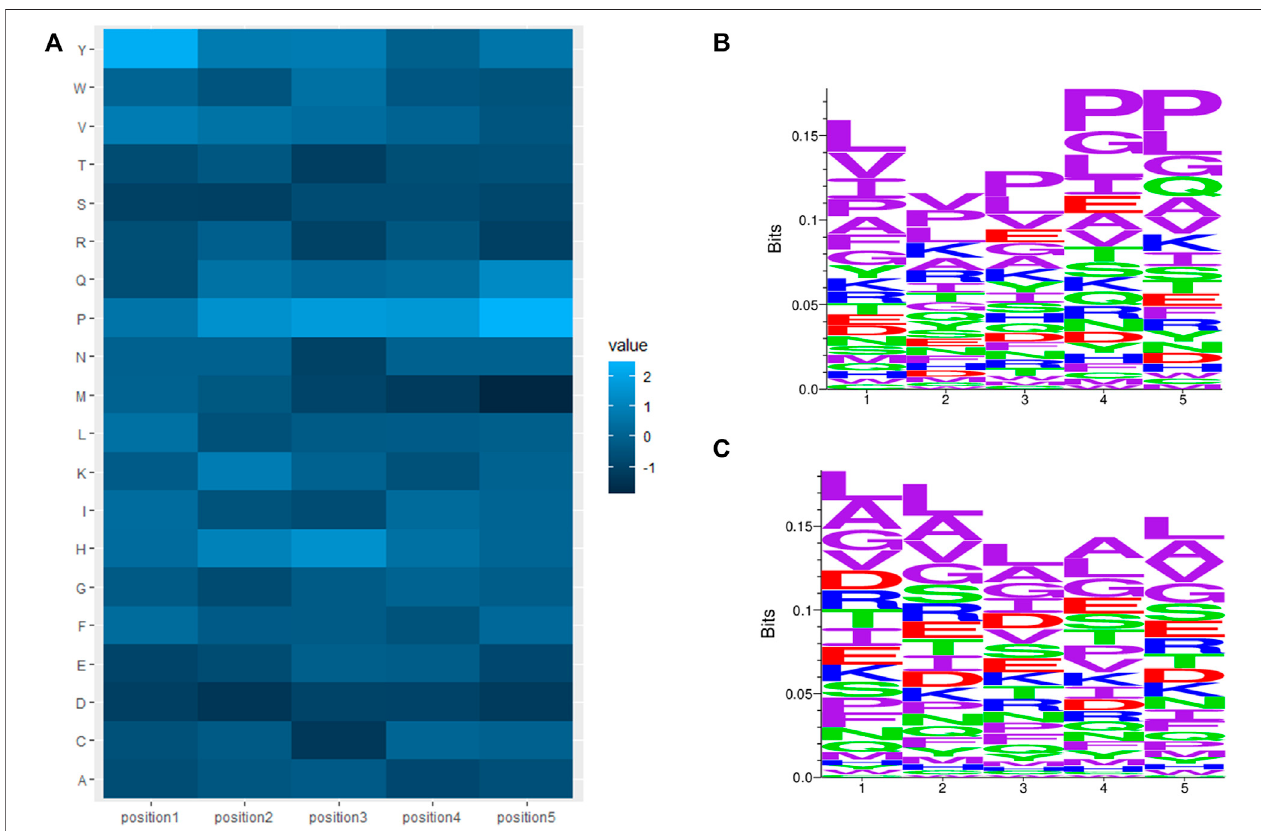
FIGURE3| N-terminalfeaturesofAHTPpositivedataandnon-AHTPnegativedata: (A) Heatmapoflogoddsratios,wherealightercolordenotesoverrepresented amino acid residues in AHTPs compared to non-AHTPs (positive log odds score) and, a darker color denotes underrepresented amino acid residues in AHTPs comparedtonon-AHTPs(negativelogoddsscore). (B) Sequencelogosofpositionsoneto fi veoftheAHTPpositivedataset. (C) Sequencelogosofpositionsoneto fi ve of the non-AHTP negative